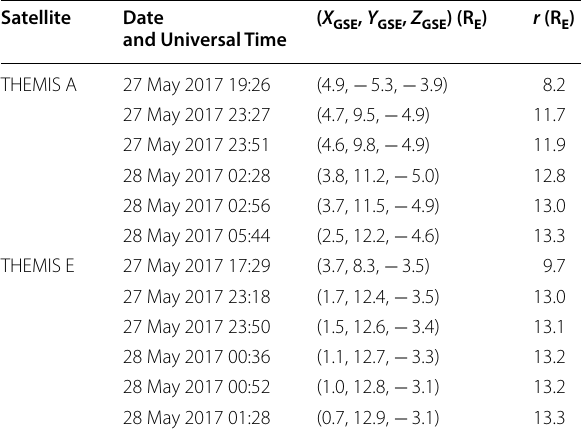
Table 3 Magnetopause crossings for